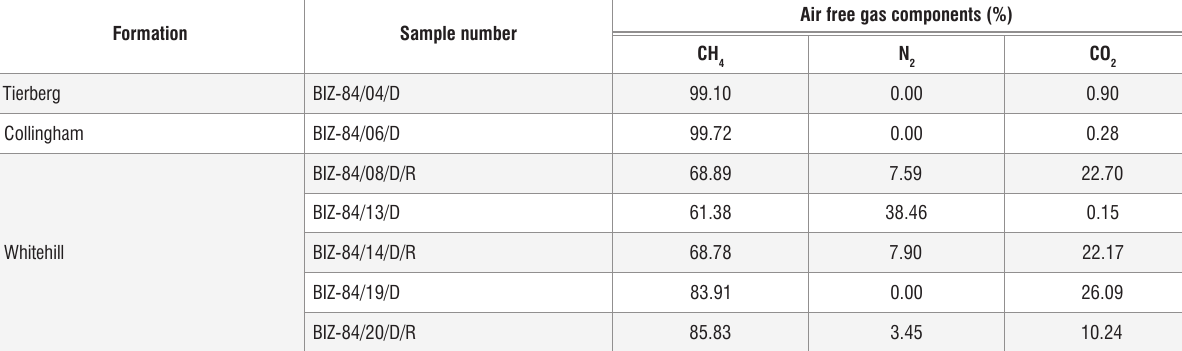
Table 2: Residual gas composition in KZF-01 Formation Tierberg